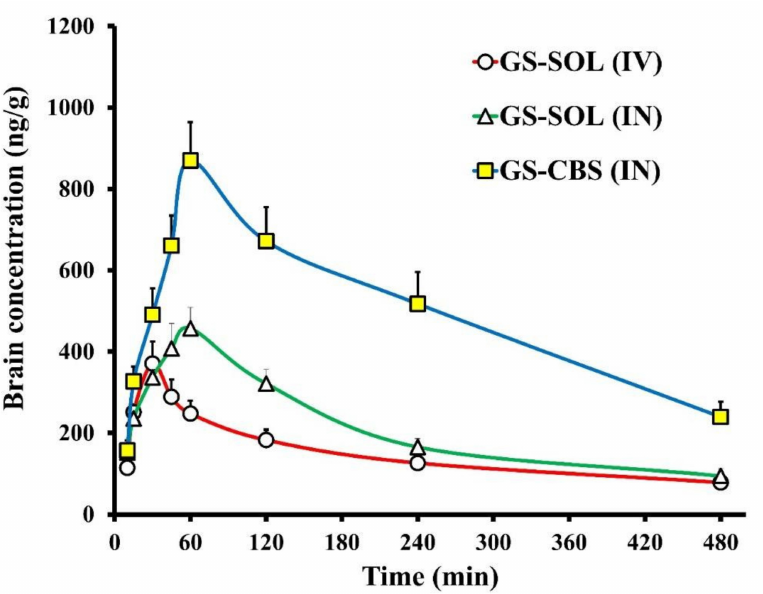
Figure 9. Granisetron levels in rat brain following GS-SOL (IV), GS-SOL (IN) and GS-CBS (IN) ad- ministration.